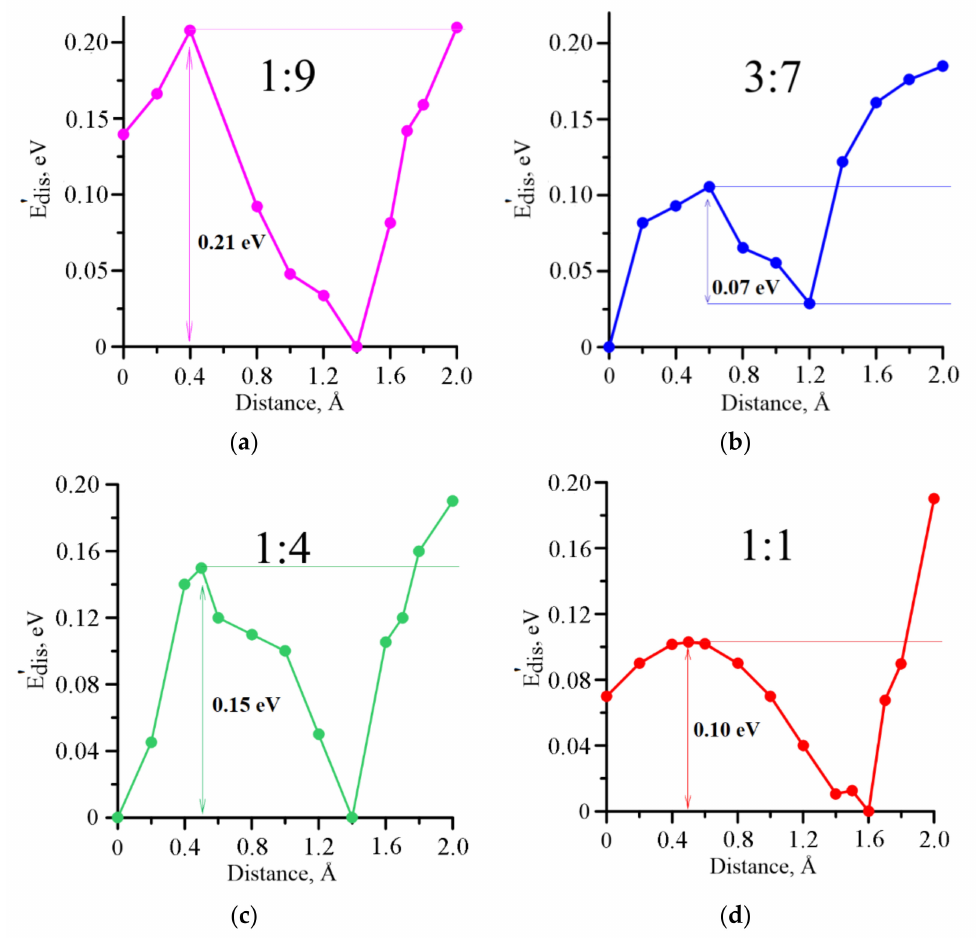
Figure 2. The dependence of dispersion energy on the distance between graphene and the Fe 3 O 4 particle for different mass ratios of m(Fe 3 O 4 ):m(G): ( a ) 1:9; ( b ) 3:7; ( c ) 1:4; ( d )